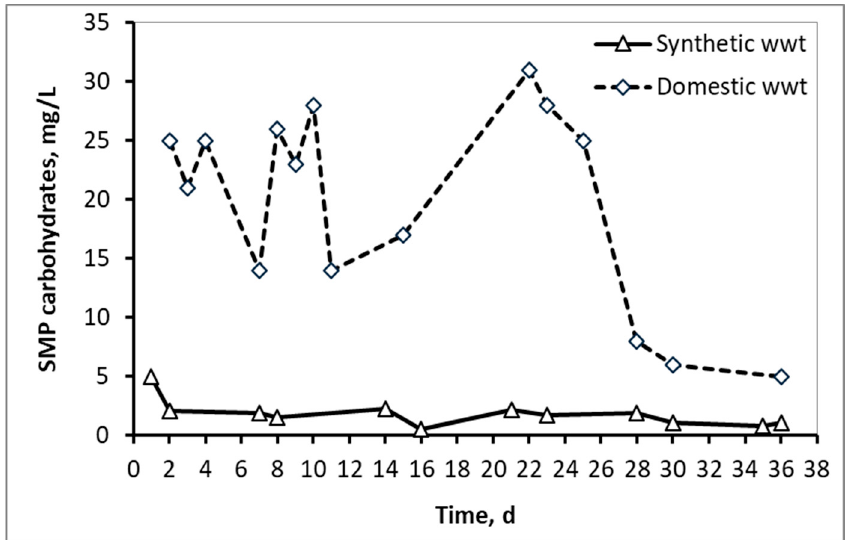
Figure 4. SMP concentration in the form of carbohydrates in the mixed liquor of synthetic and domestic wastewater.